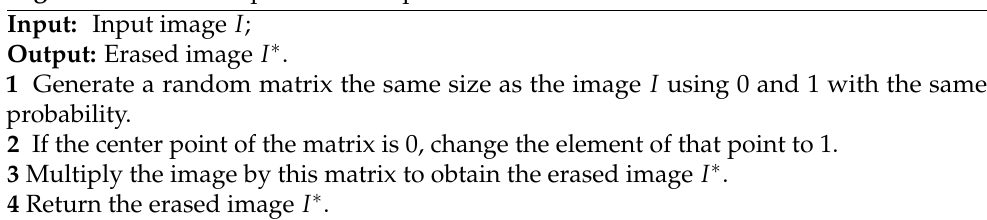
Algorithm 2 Random point erasure procedure